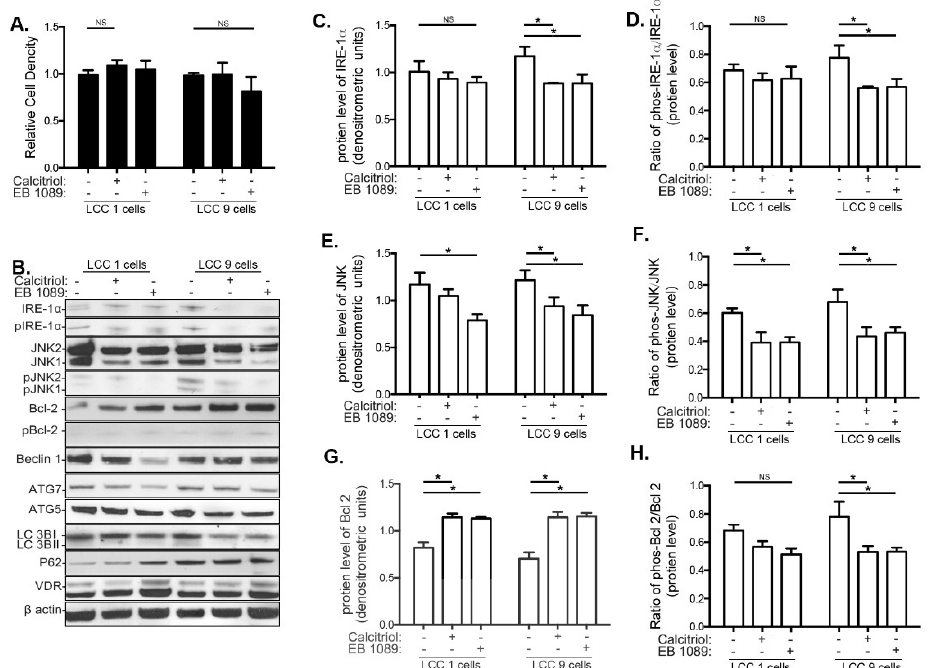
Figure 3. Calcitriol and EB1089 inhibited the activation of the IRE1 α -JNK signaling pathway in breast cancer cells. Cells were treated with vehicle (ethanol), calcitriol (100 nM) or EB1089 (100 nM) for 7 days. ( A ) Relative cell density, as determined by crystal violet assay. ( B ) Representative Western blots of the IRE1 α -JNK signaling pathway, and quantification of changes in protein expression of three independent biological replicates of ( C ) total IRE1 α , ( D ) the ratio of pIRE-1 α over total IRE-1 α , ( E ) total JNK, ( F ) the ratio of pJNK over total JNK, ( G ) total Bcl-2, and ( H ) the ratio of Bcl-2 over total Bcl-2. β -actin was used as a loading control. * p < 0.05, NS: Not significant.